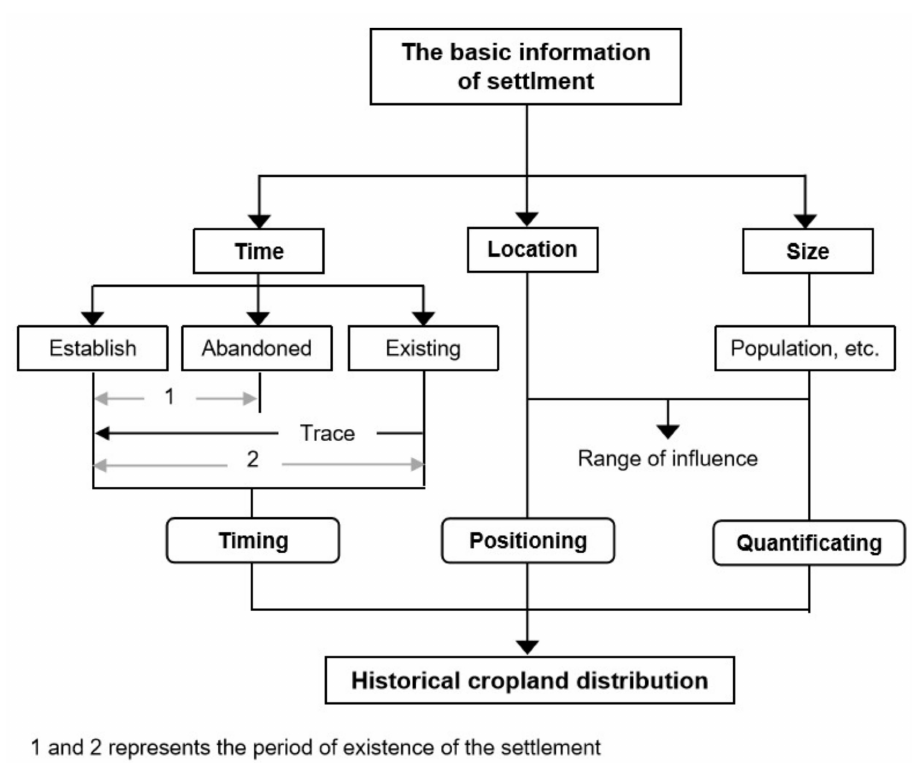
Figure 3. The use of basic information on settlements to indicate the distribution of